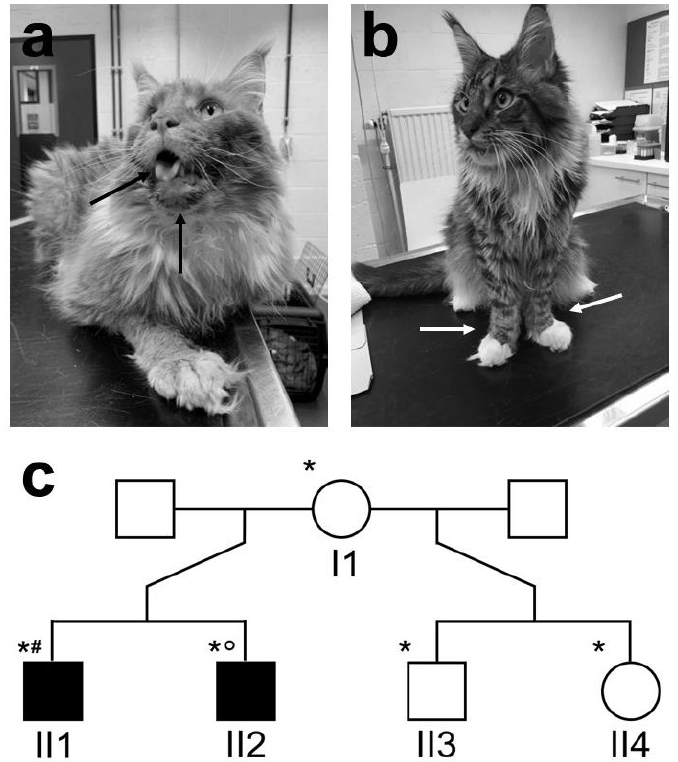
Figure 1. Image of affected cases with pedigree. ( a ) Case 1 (individual II1 in c) at the age of 3 years old, showing tongue hypertrophy, visible in the mouth and beneath the mandibula (black arrows). ( b ) Case 2 (Individual II2 in c), showing internally rotated carpi of the thoracic limbs (white arrows). ( c ) Pedigree with numbering of the individuals. Sample availability is indicated by a * for an EDTA blood sample, a ° for a muscle biopsy for genetic analysis, and a # for a muscle sample for histopathology and immunofluorescent staining.